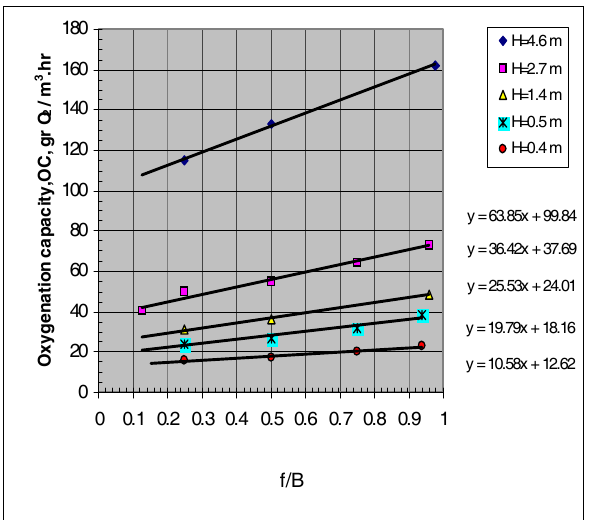
Figure 6: Effect of (f/B) ratios on the oxygen transfer capacity (OC) of the system at constant air flow